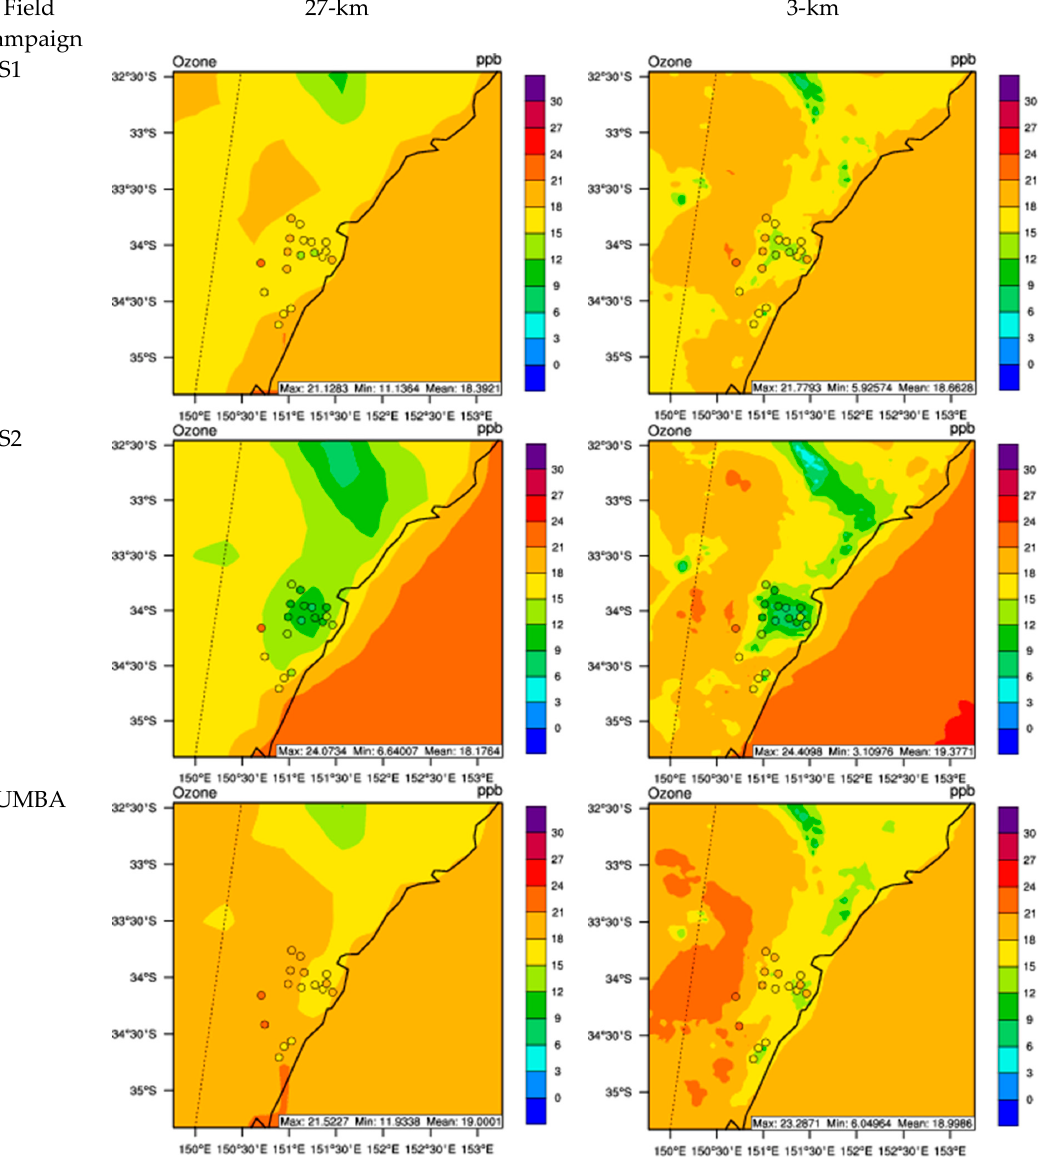
Figure 5. Simulated spatial distribution of surface concentrations of O 3 overlaid with observations over the Greater Sydney area (d04). All simulation results are based on WRF/Chem-ROMS.